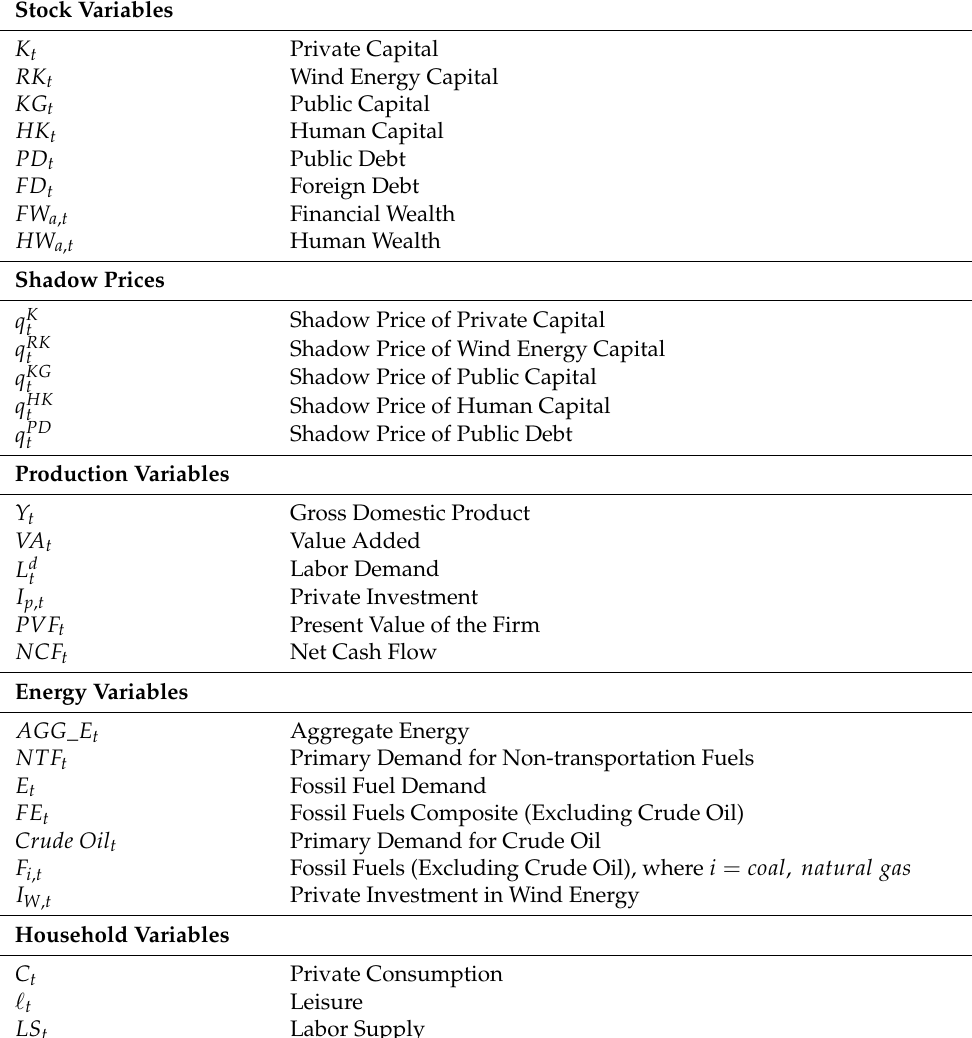
Table A4. The dynamic general equilibrium model—model